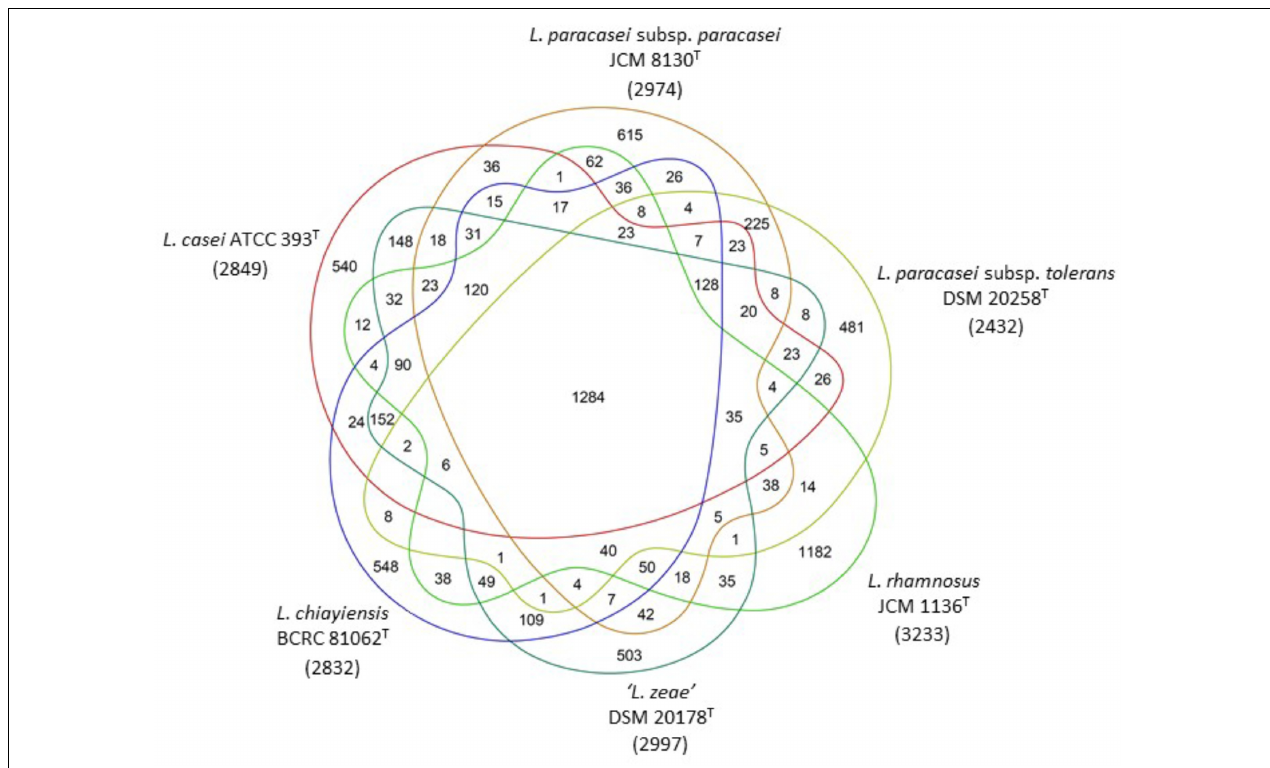
FIGURE 4 | Ortholog analysis among six type strains in the L. casei group. Gene prediction and annotation were performed by RAST automated web server. Venn diagram showing the number of core, shared and unique genes for each genome. Numerals in parentheses under strain name are the numbers of the predicted